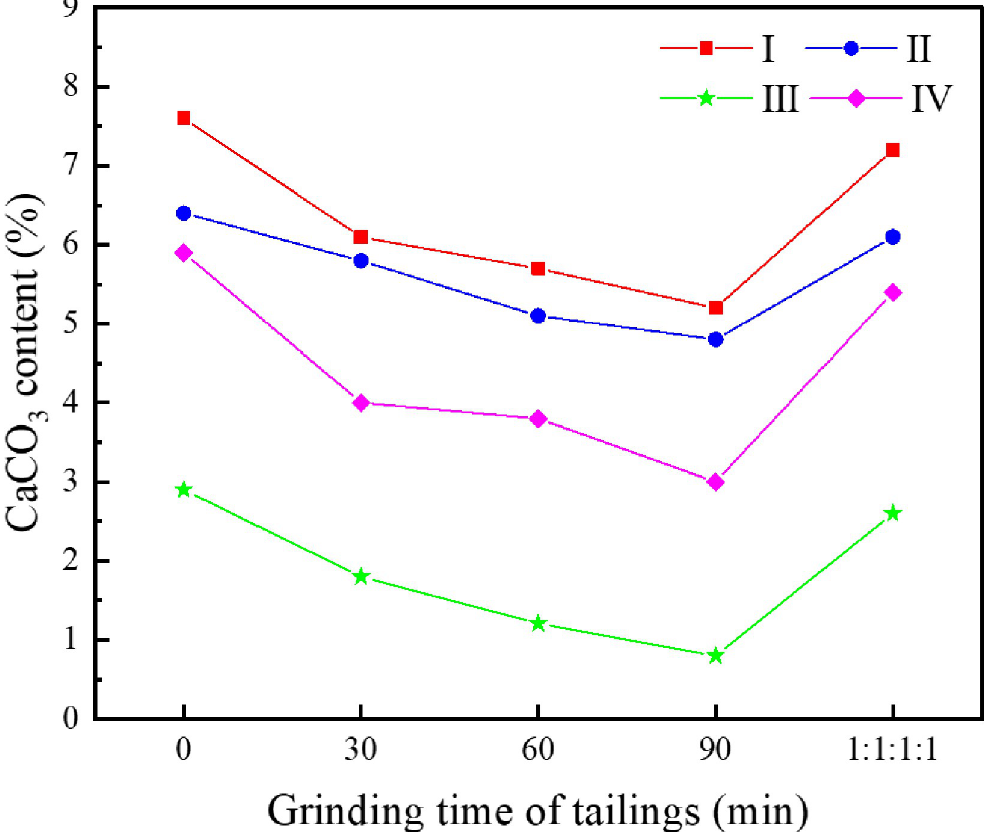
Fig 14. Relationship between tailings particle size and CaCO3 content in different